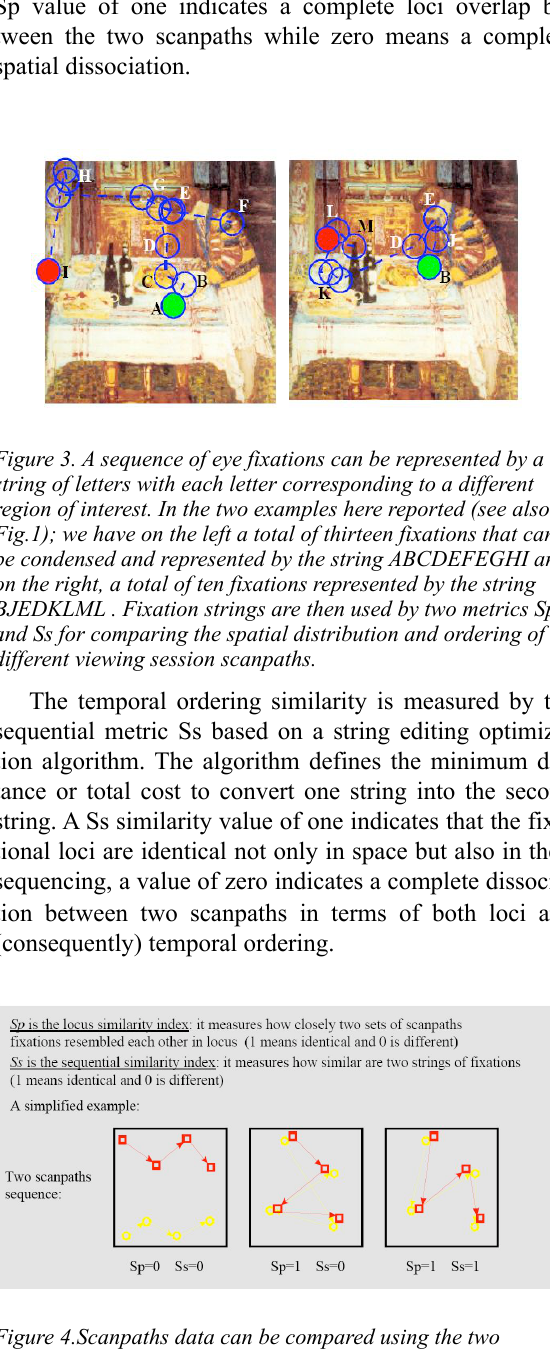
Figure 4.Scanpaths data can be compared using the two metrics, Sp and